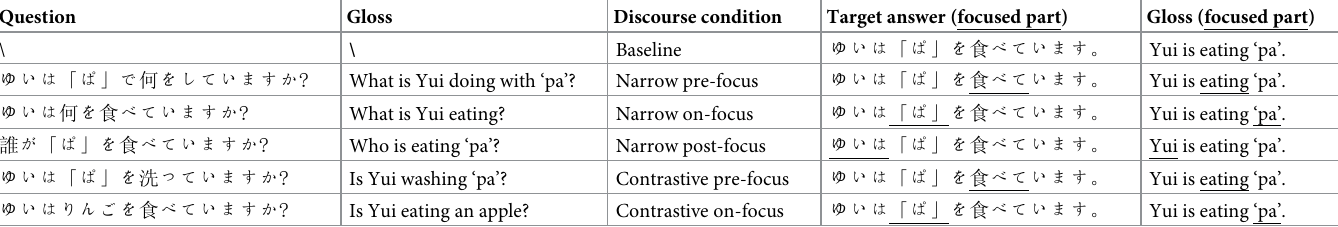
Table 2. Examples of Japanese target syllables in various discourse conditions (focused parts are highlighted underlined and in bold).